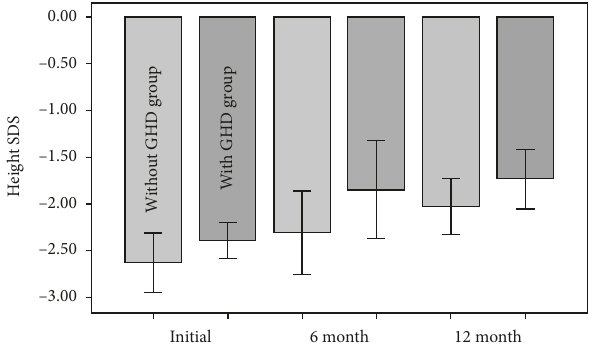
Figure 1: No significant changes in height standard deviation scores (SDS) in the two groups based on whether they had growth hormone deficiency